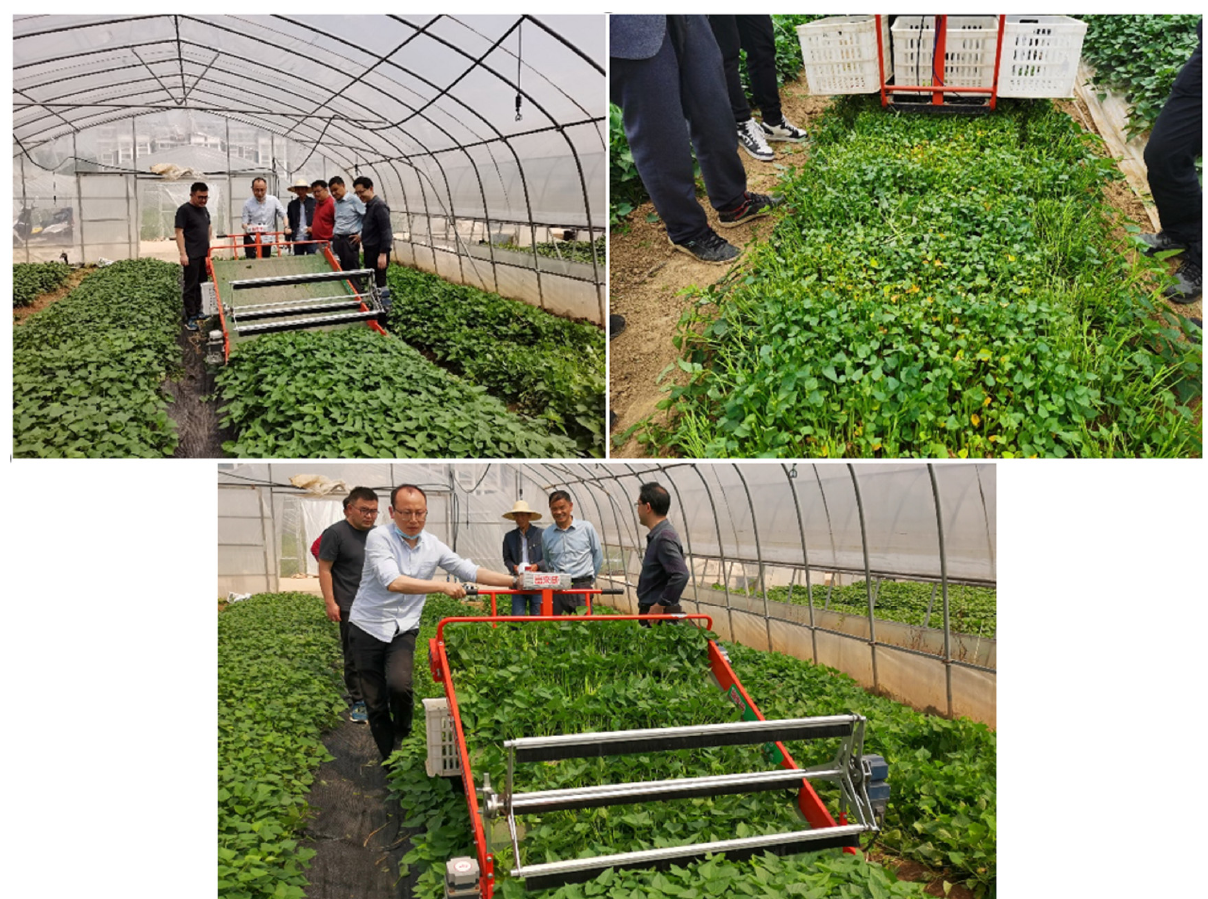
Figure 12. Field operation diagram for the 4UM-120D electric leafy vegetable harvester.